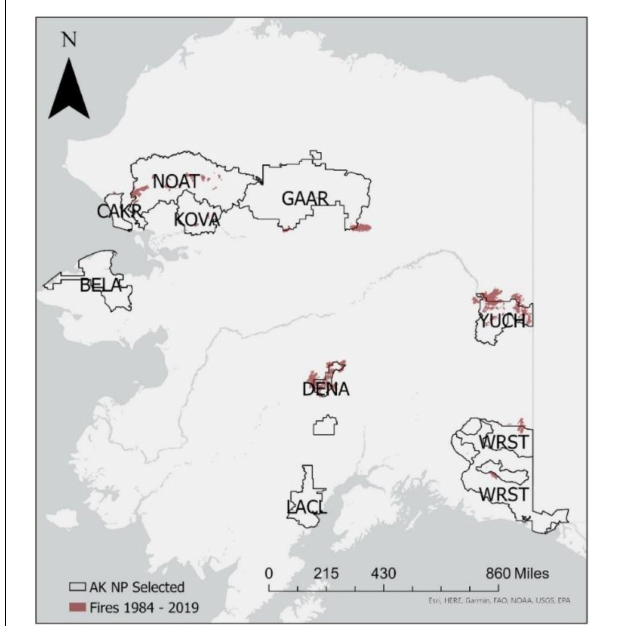
FIGURE 1 | Locations of the nine Alaska national parks analyzed in this study and the large fires ( > 405 ha) occurred from 1984 to 2019 in or near those